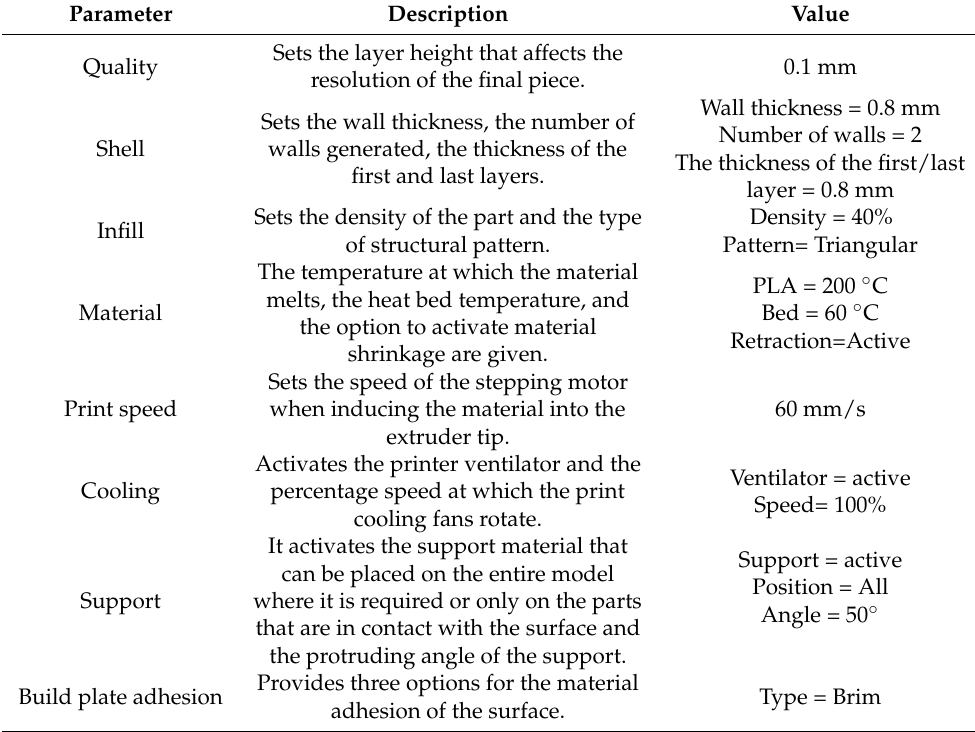
Figure 17. Cosmetic component of arm-1 of the upper limb prosthesis in Ultimaker Cura ®. After importing the STL format model, we proceeded to configure the parameters of Table 9 in Ultimaker Cura ® . Table 9. Configuration Ultimaker Cura ® for manufacturing FDM material